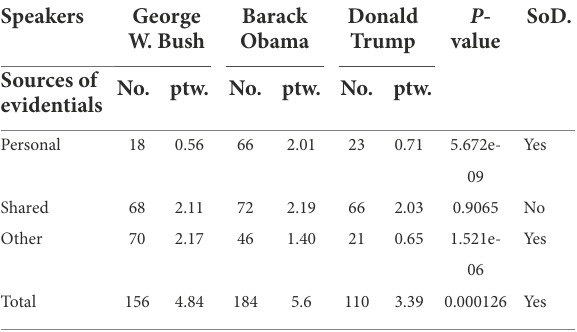
TABLE 2 A comparison of sources of evidentials in three cases.